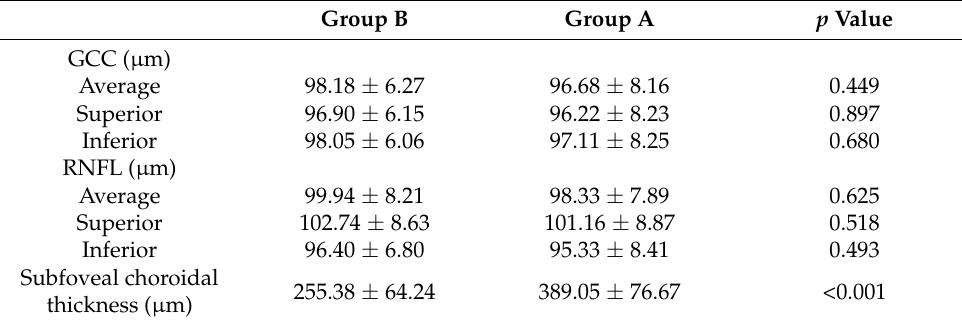
Table 2. Differences in OCT parameters between controls and